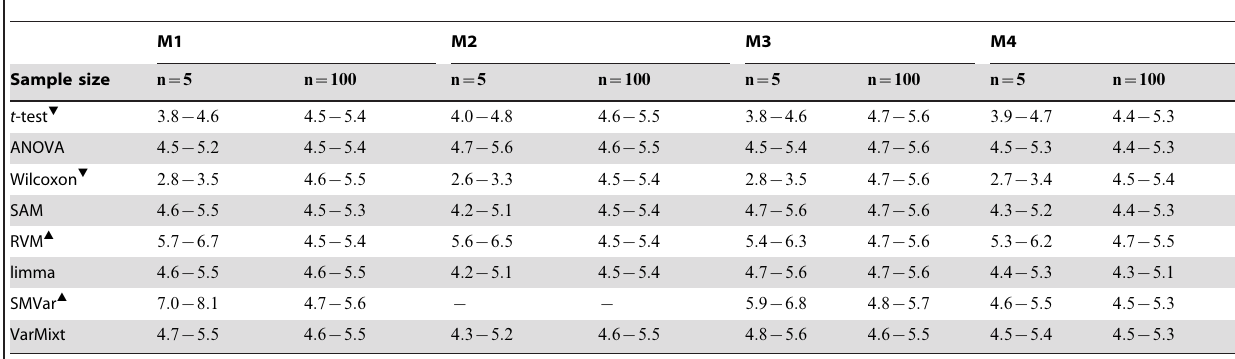
Table 2. False-positive rate study from simulations.